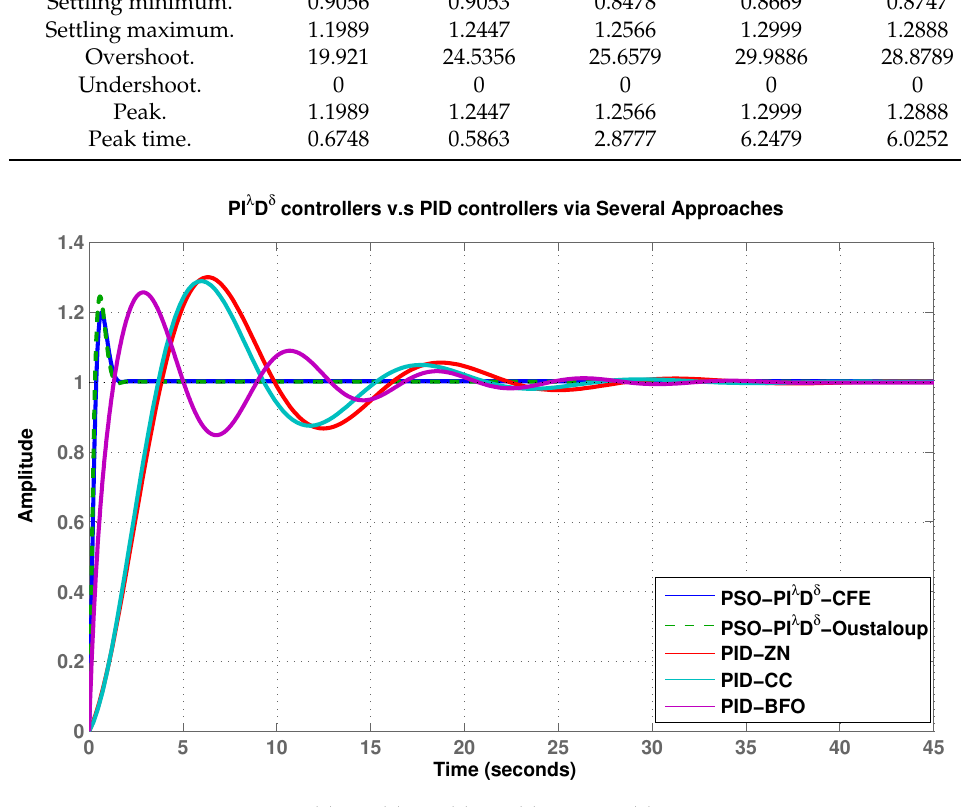
Figure 3. Step responses of H 6 ( s ) , H 7 ( s ) , H 8 ( s ) , H 9 ( s ) and H 10 ( s )